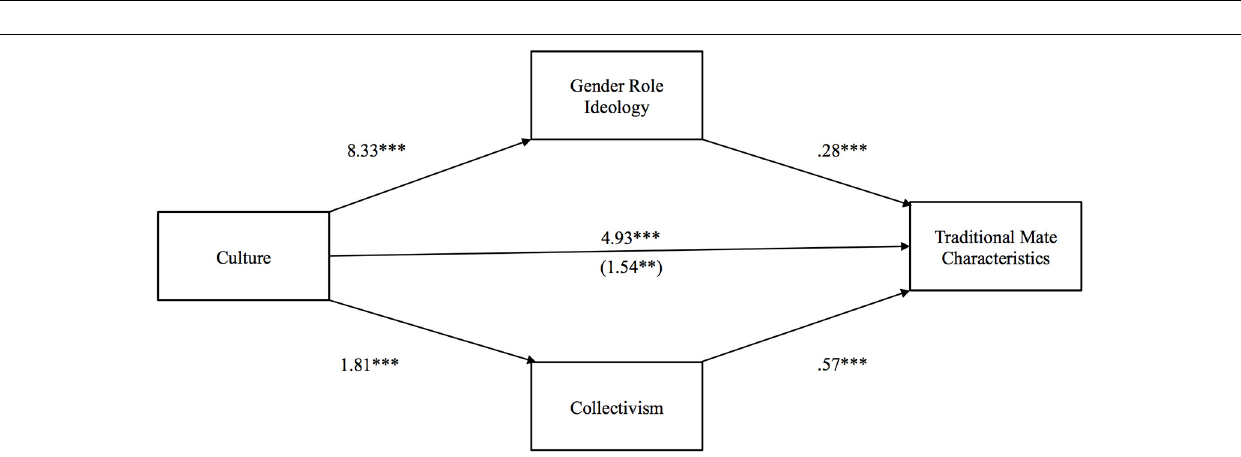
FIGURE 1 | Indirect effect of culture on romantic beliefs through gender role ideology and collectivism. The value in parentheses represents the direct effect, and the value directly above is the total effect. ∗ p < 0 . 05, ∗∗ p < 0 . 01, ∗∗∗ p < 0 . 001.